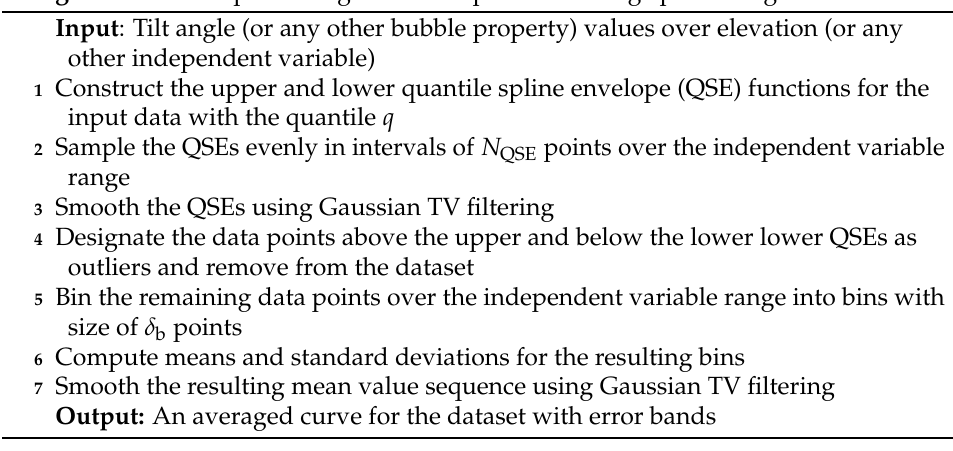
Algorithm 7: Post-processing for the output of the image processing code.